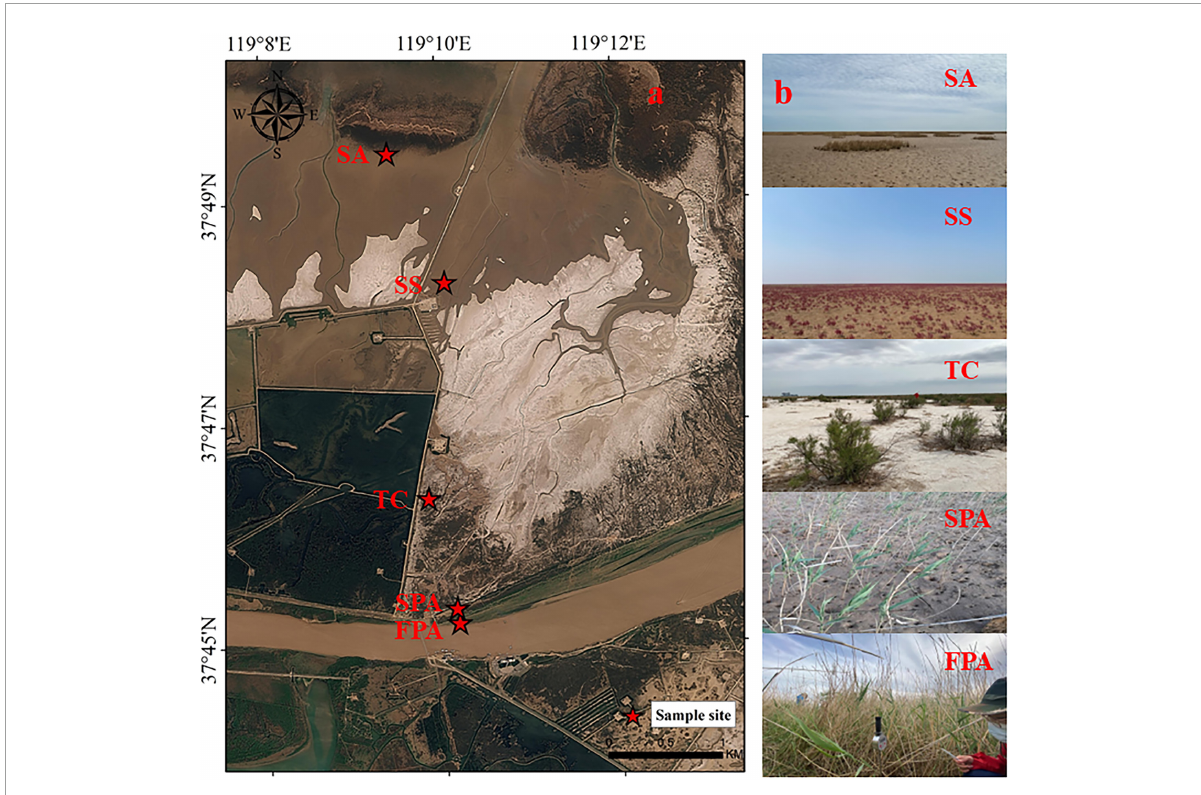
FIGURE1 The sample sites (a) and plant communities (b) in the study area. FPA, P . australis in freshwater marsh; SPA, P . australis in salt marsh; TC, T . chinensis in salt marsh; SS, S . salsa in salt marsh; SA, S . alterniflora in salt marsh.